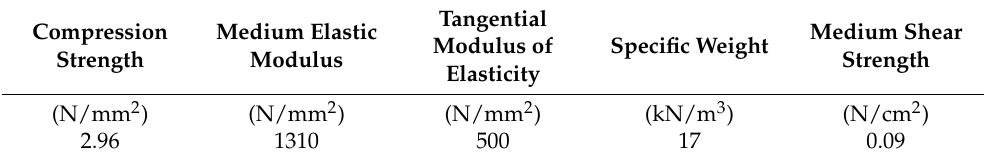
Table 1. Mechanical characteristics of masonry walls.